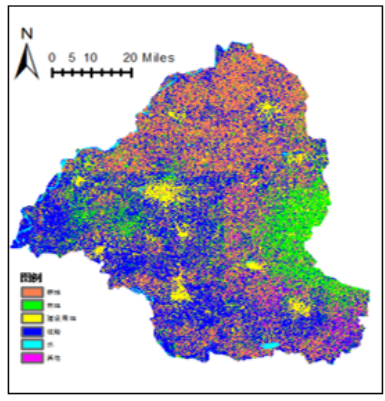
Figure 3 ． Result of maximum likelihood classification results